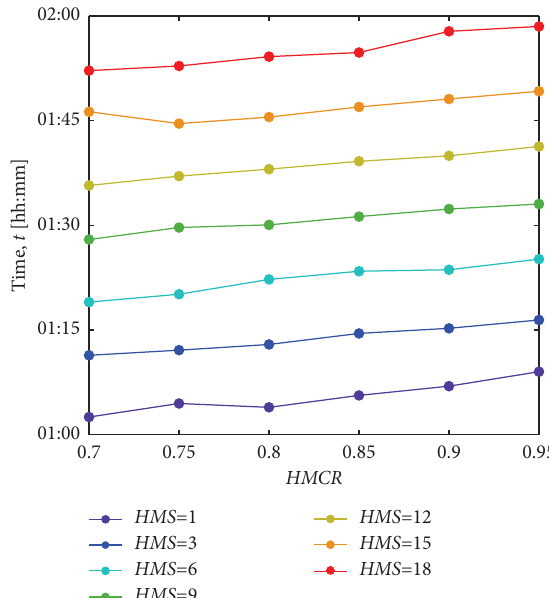
Table 1: Number of improvisations required to reach 􏽢 P